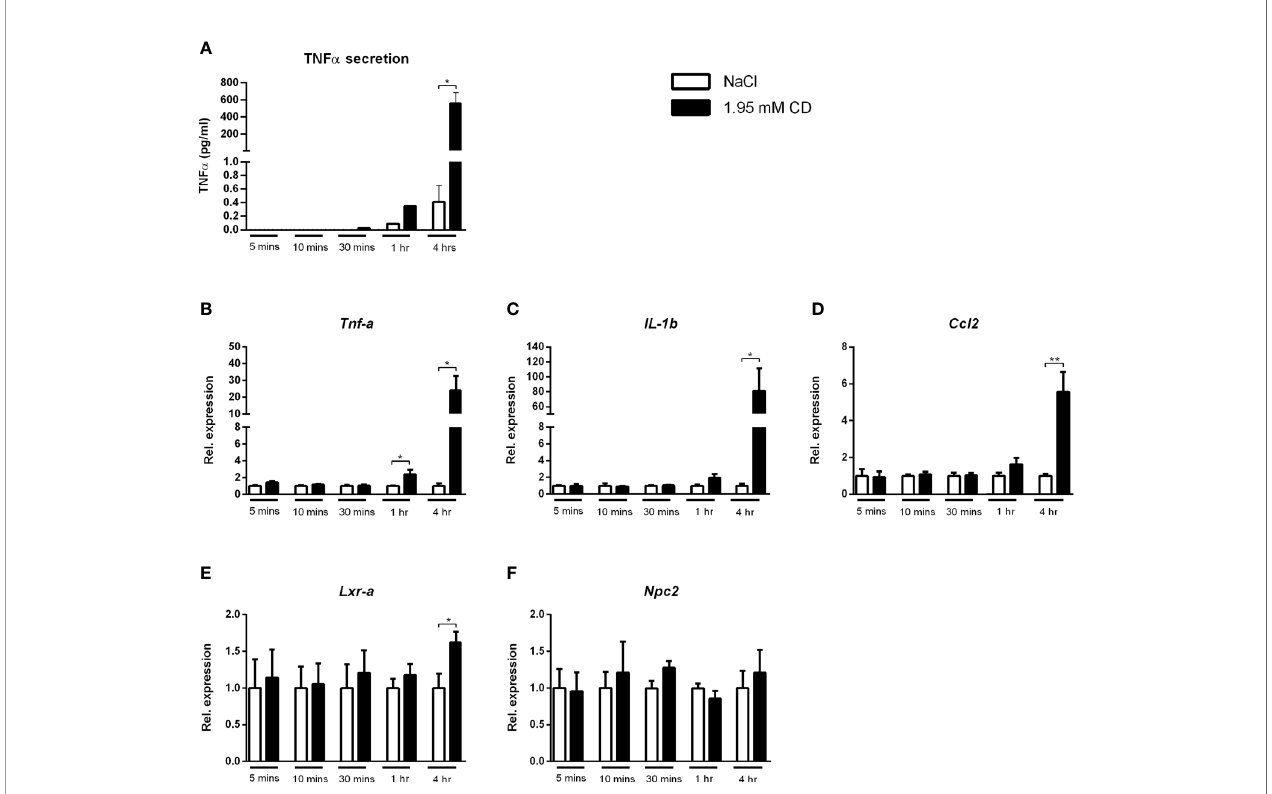
FIGURE 7 | Time dependency of the in fl ammatory effect of 2-hydroxypropyl- b -cyclodextrin. (A) TNF a protein levels of Wt BMDM treated with 2-hydroxypropyl- b - cyclodextrin for different time durations. (B – D) Gene expression analysis of Tnf a , IL-1b, Ccl2. (E, F) Gene expression analysis of Lxr a and Npc2. Gene expression data were set relative to Wt BMDM treated with saline. Data are the result of 2 independent experiments. *, ** indicates p < 0.05 and 0.01 by means of unpaired t-test.